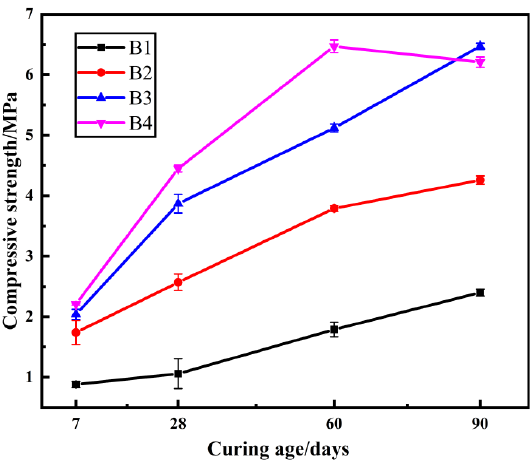
Figure 2. Strength of samples at different curing ages, varying the quicklime dosage.